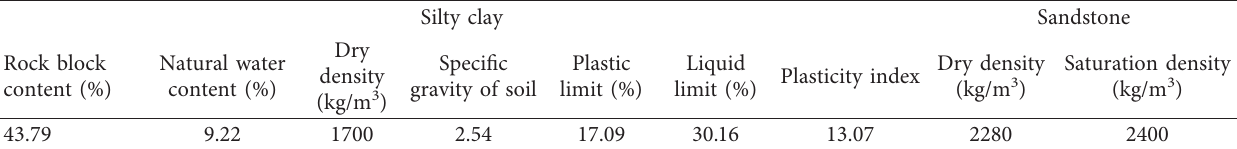
Table 1: Summary of physical and mechanical properties of soil-rock mixture backfill.